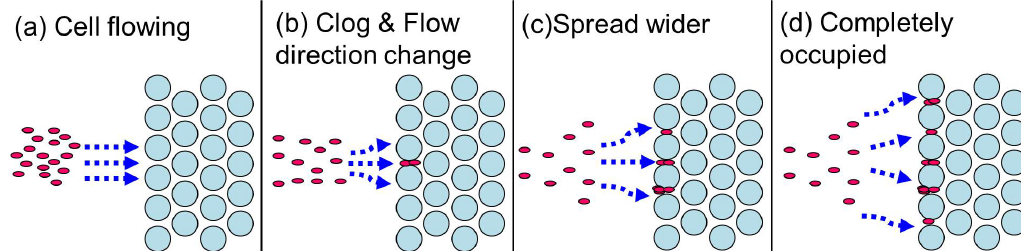
Figure 2. Schematic illustration of clogging process. ( a ) Cells flow straight toward the micropillar array. ( b ) When the cells reach the micropillar array, they become clogged at gaps between the micropillars. The clogged cells cause the flow direction change. ( c ) Other cells arrive at the micropillar array and become clogged at other gaps, changing the flow direction again. ( d ) The gaps at the front of the micropillar array become fully clogged. Blue arrows indicate the direction of cell motion.